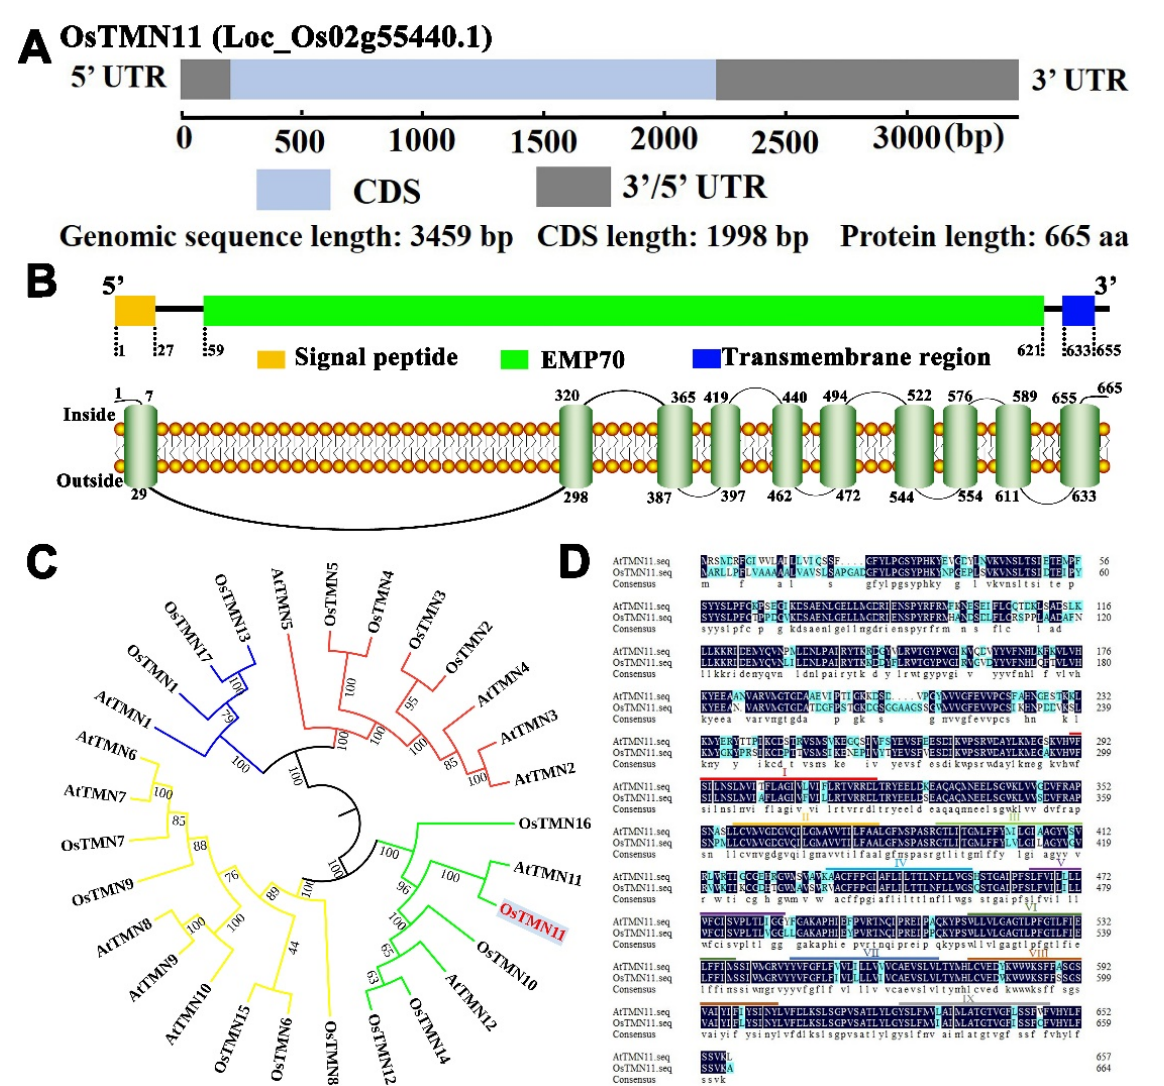
Figure 1. Analysis of OsTMN11 gene and protein structures and relationship with its homologues in Arabidopsis. ( A ) Diagram of OsTMN11 structure. CDS, coding sequence. UTR, untranslated regions. aa, amino acid. ( B ) Diagram of structural transmembrane domain of OsTMN11. EMP70, endomembrane protein 70. ( C ) Phylogenetic relationship between OsTMN11 and its homologues in rice and Arabidopsis. ( D ) Diagram of sequence similarity for OsTMN11 and AtTMN11.